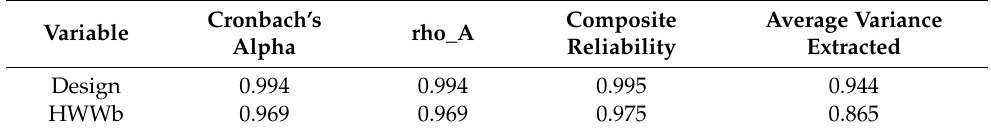
Table 8. Reliability and Average Variance Extracted.